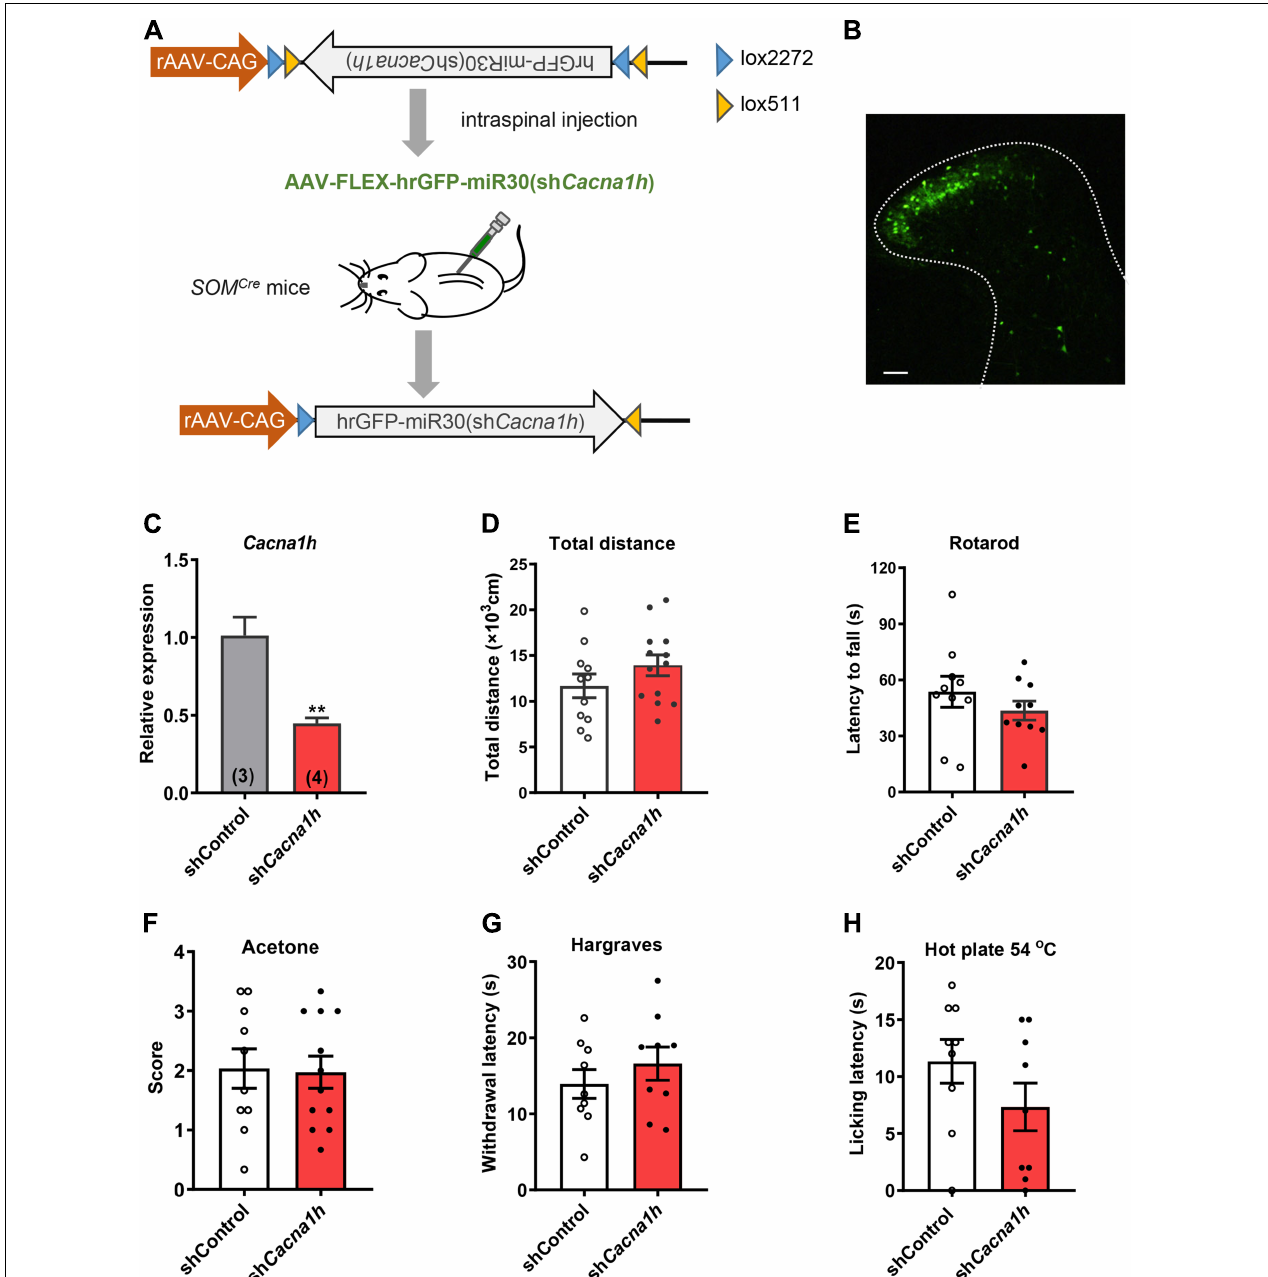
FIGURE 3 | Knockdown of Cacna1h in spinal SOM + neurons does not affect motor ability or thermal sensations in naïve mice. (A) Schematic illustration of viral-mediated knockdown of Cacna1h in spinal SOM + neurons through intraspinal injection. Non-silence shRNA virus was used as a control. (B) Expression of the GFP-tagged virus in the spinal cord. Scale bar, 100 µ m. (C) qPCR analysis of the relative expression level of Cacna1h 28 d after injection of Cacna1h knockdown virus. Non-silence shRNA virus was used as a control. (D–H) Behavioral tests of motor ability and thermal sensations in the mice after knockdown of Cacna1h in spinal SOM + neurons. The total distance traveled in the open field (D) , the latency to fall in the rotarod (E) , the behavioral responses to acetone-evoked cooling (F) , the withdrawal latency in the Hargreaves test (G) and the licking latency in the hot plate at 54 ◦ C (H) were unaffected by Cacna1h knockdown in spinal SOM + neurons. Student’s unpaired t